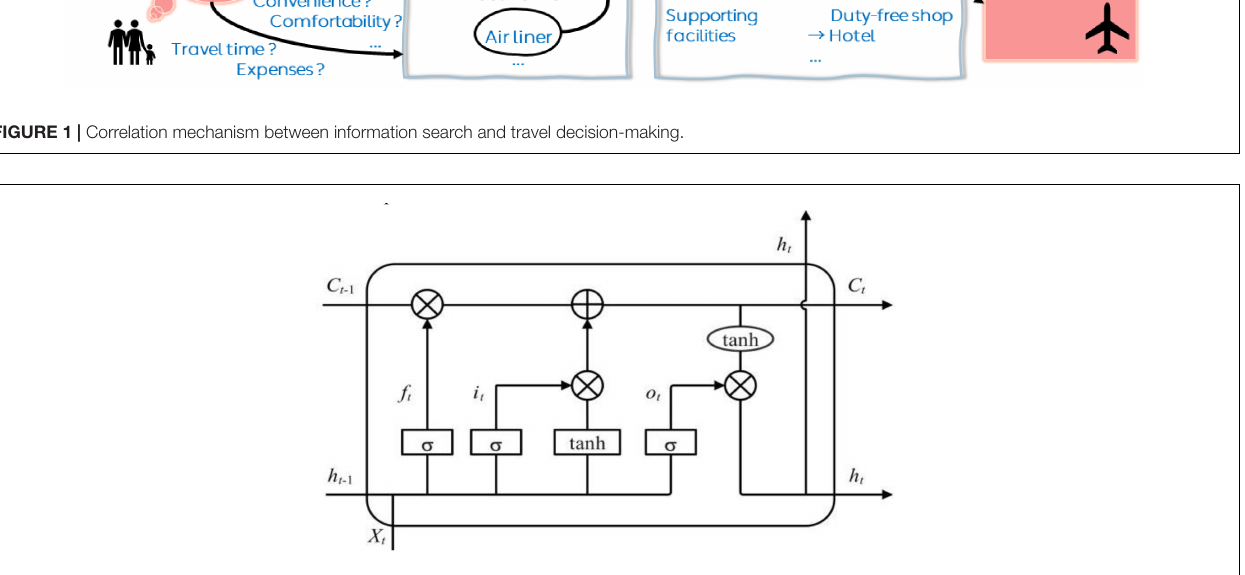
FIGURE 2 | Structure of an long short-term memory (LSTM) memory cell.